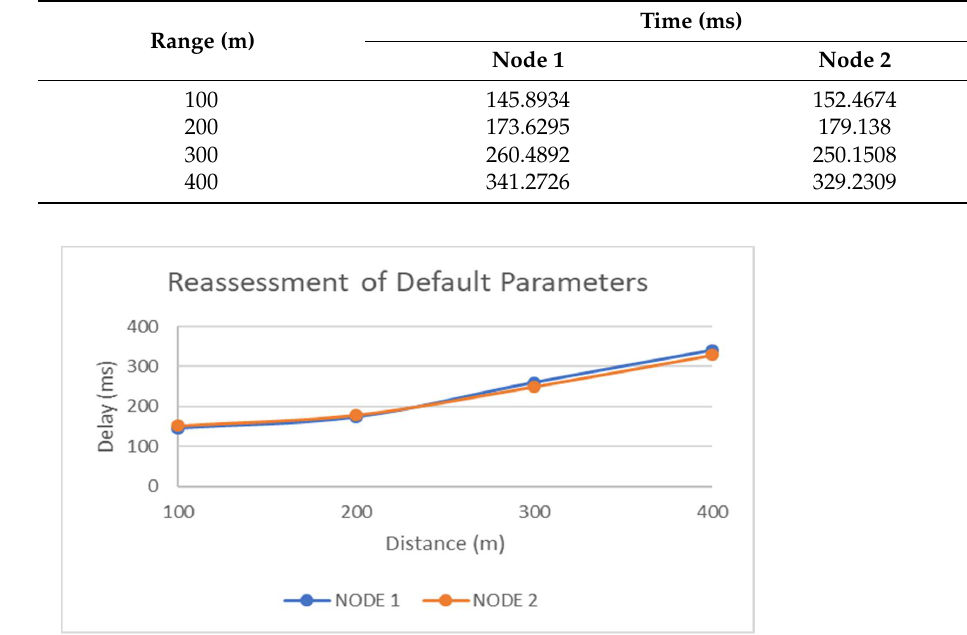
Figure 10. Reassessment of default parameters.